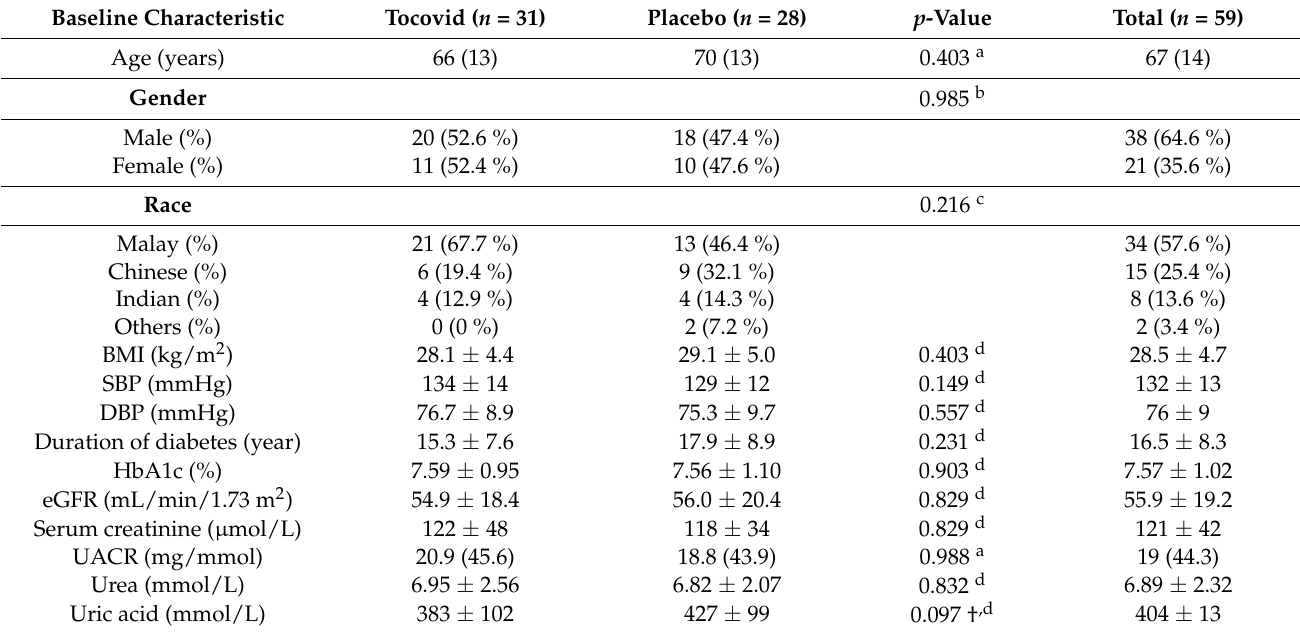
Table 1. Baseline characteristics of 59 patients before